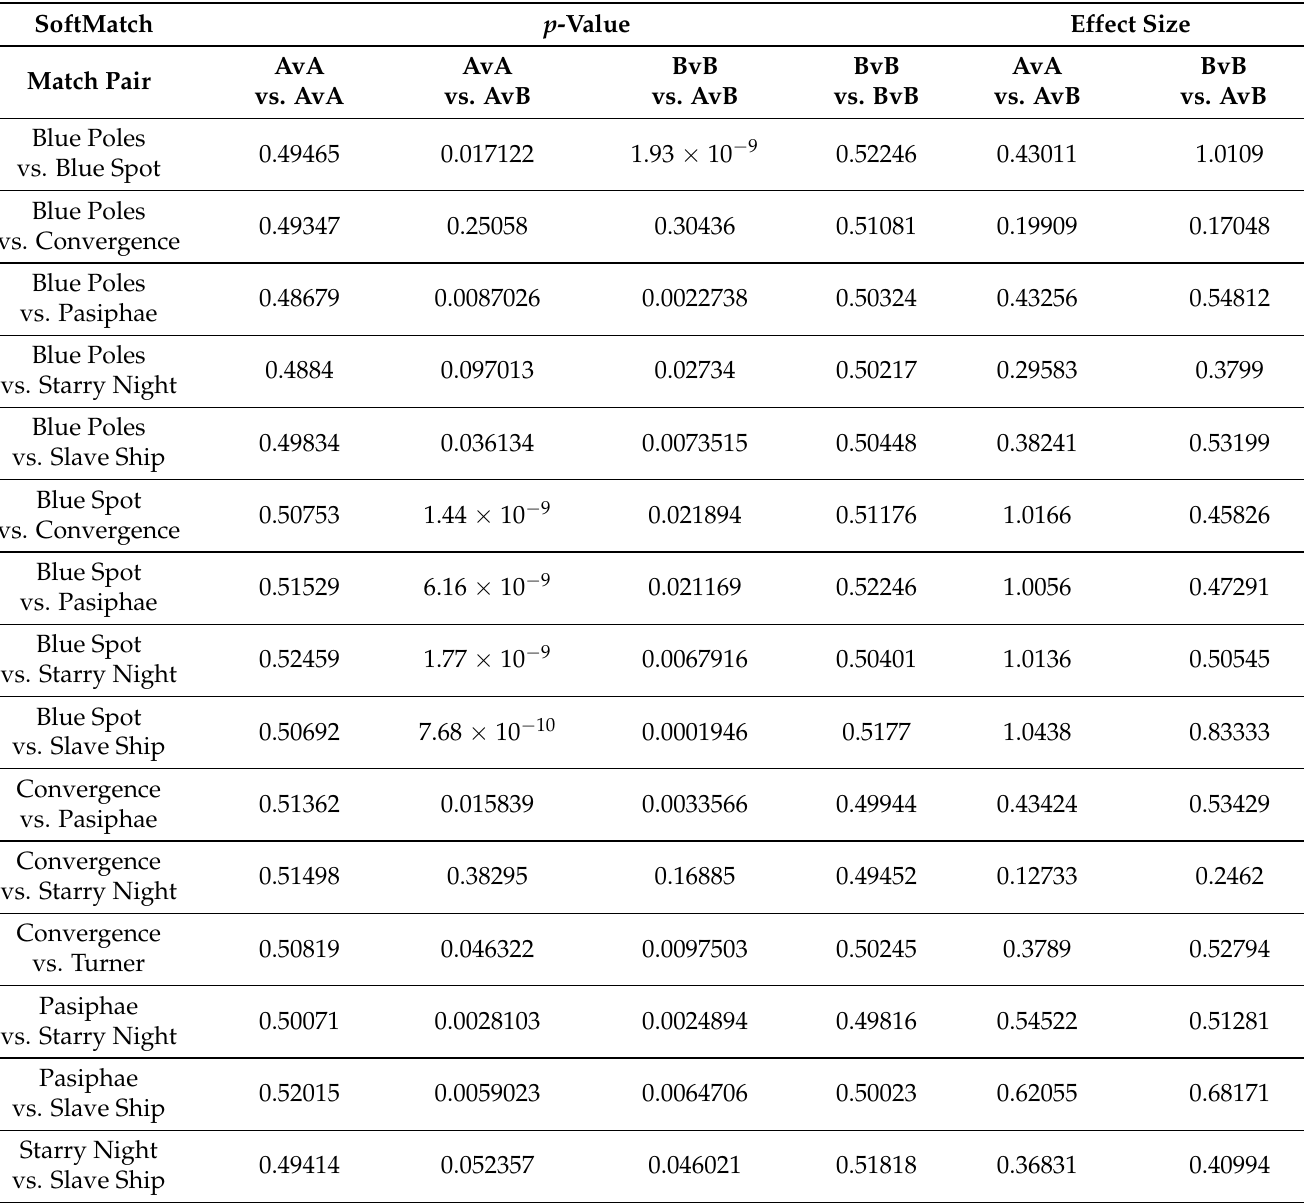
Table A1. SoftMatch results. Match pair (e.g., Blue Poles vs. Blue Spot) where AvA, AvB, and BvB represent match scores based on a comparison of the one member of the pair with itself, or the first member of the pair ( A ) (e.g., Blue Poles) and the second member, B (e.g., Blue Spot). The effect size for (AvA vs. AvA) and (BvB vs. BvB) in all cases was